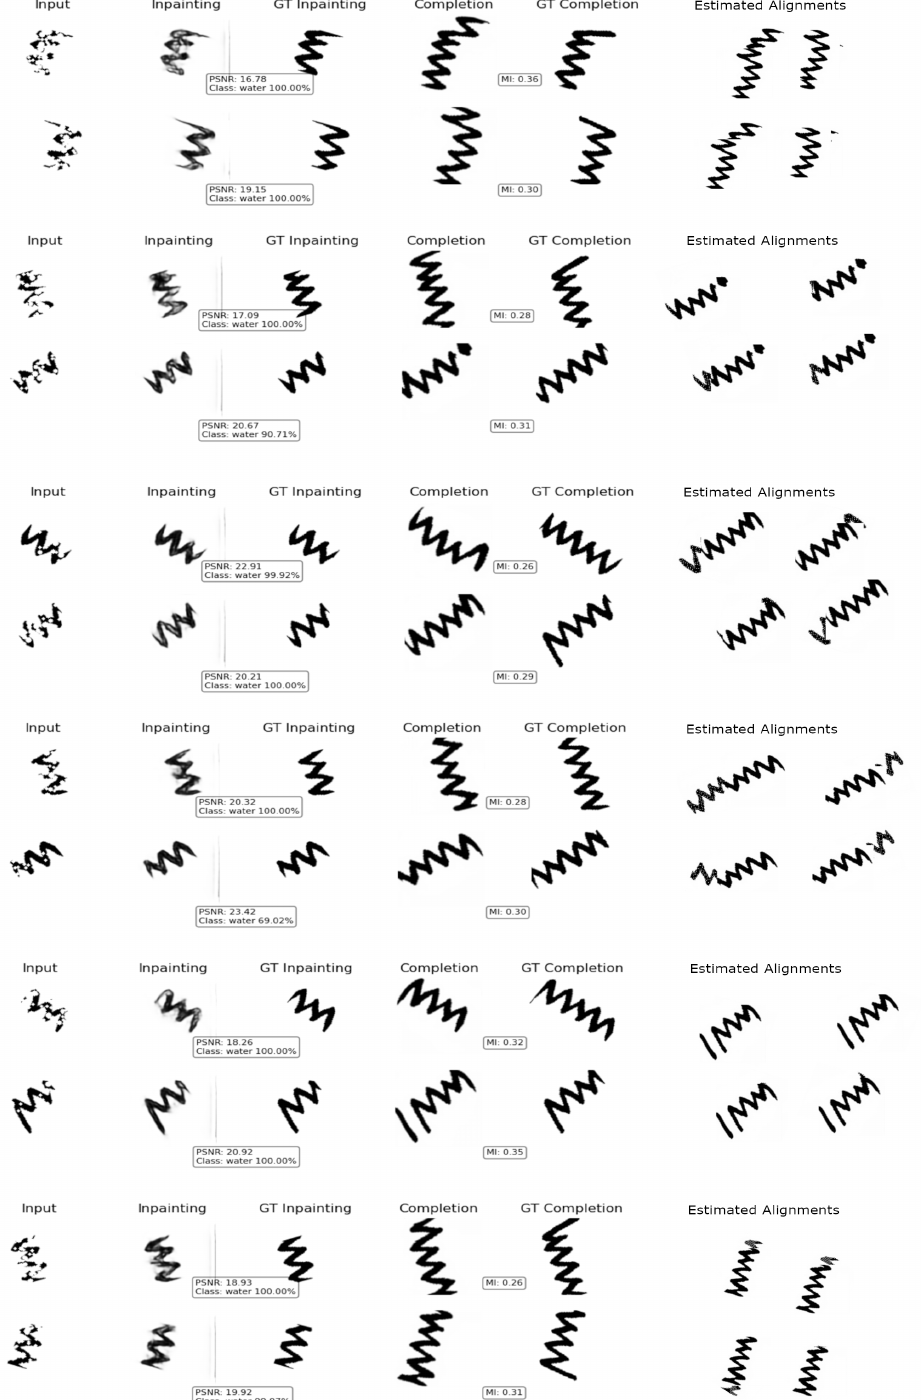
Figure 16. Examples of obtained results for the water sign. From inpainting to